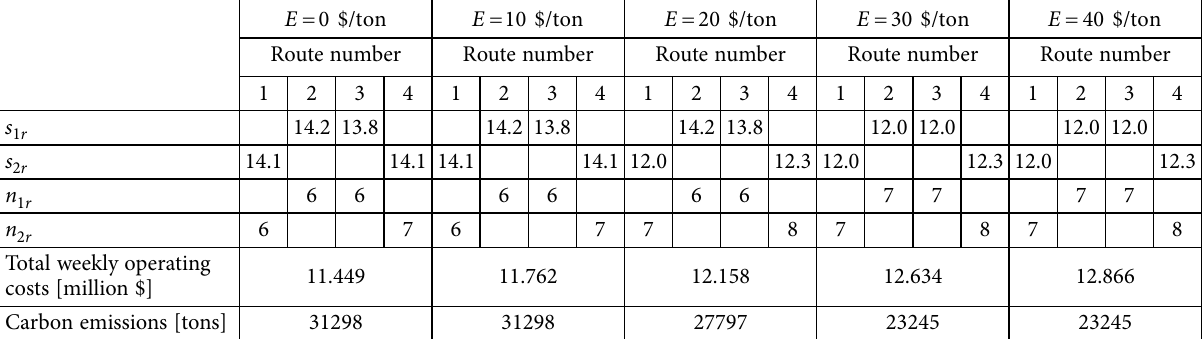
Table 6. SSFDP optimization results under different carbon